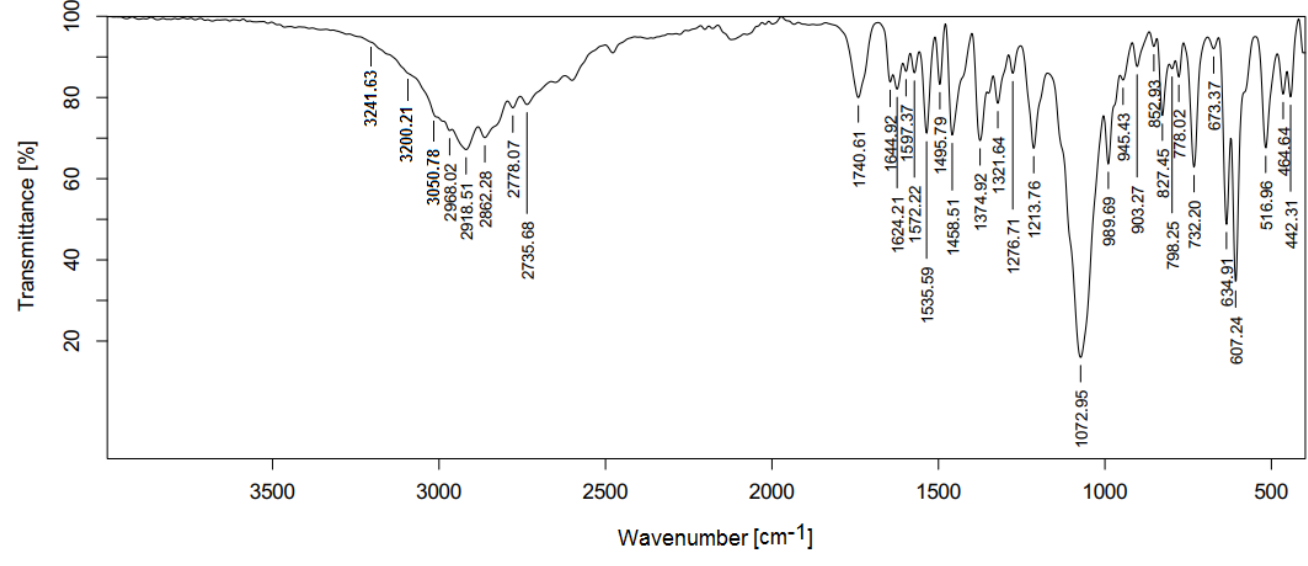
Figure 1. FT ‐ IR spectrum of CuSQ complex in 4000–400 cm –1 . Figure 1. FT-IR spectrum of CuSQ complex in 4000–400 cm –1 . Table 2. FTIR Spectral data of Salen and its CuSQ complex of 8 ‐ hydroxy quinolone. Table 2. FTIR Spectral data of Salen and its CuSQ complex of 8-hydroxy quinolone.